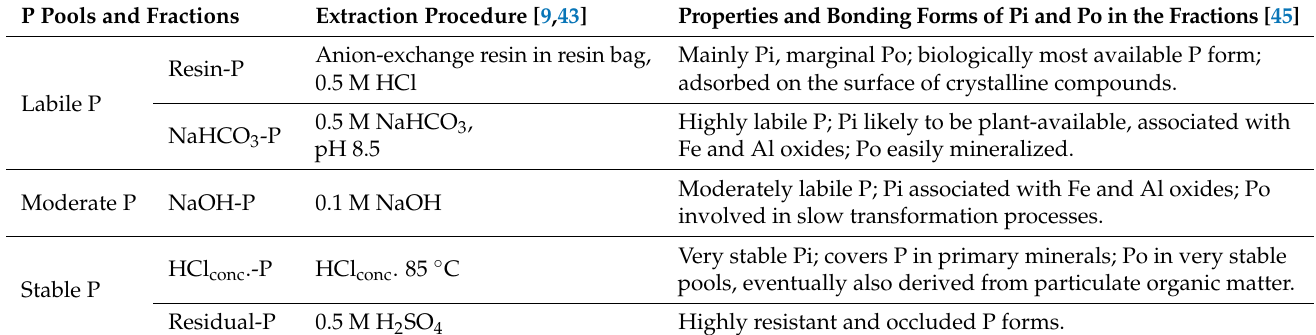
Table 2. Experimental procedure for the Hedley fractionation steps and assignment of Hedley P fractions to soil P